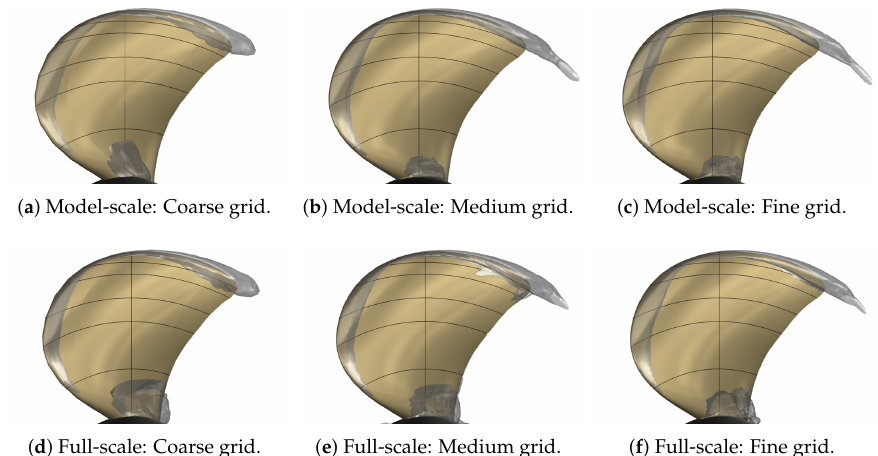
Figure 12. Comparison of near-blade cavitation results with different grid densities. PPTC Case 1 conditions, results with the SST k − ω model.